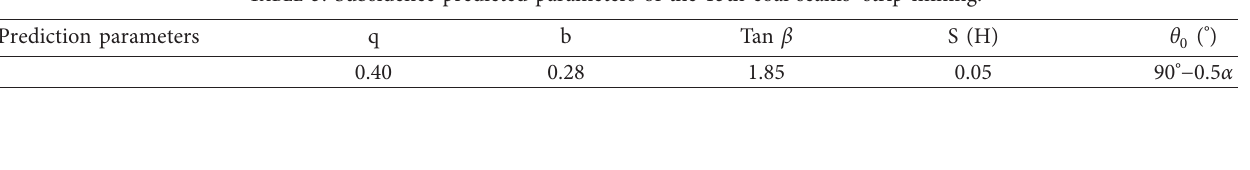
Table 6: Extremum statistics of surface movement and deformation in backfill-strip mining.